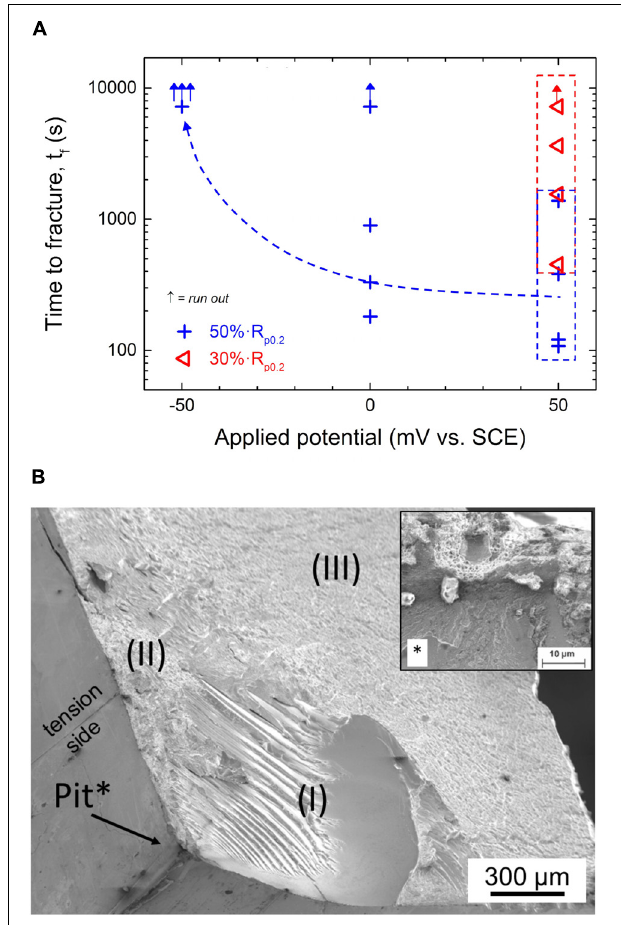
FIGURE 12 | (A) Stress corrosion cracking (SCC) test results-total time to fracture versus applied anodic potential E anodic for un-notched Vit 105 bars in 0.01 M Na 2 SO 4 + 0.01 M NaCl, starting σ max = 1,301 MPa (50% of R p0 . 2 ) and (B) scanning electron microscopy (SEM) image of fracture surface of un-notched Vit 105 sample after SCC testing (for I–III, see